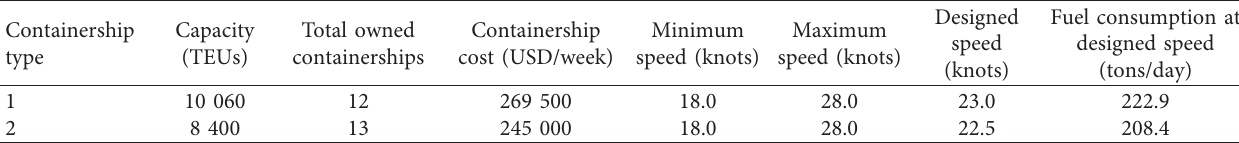
Table 4: Containerships.